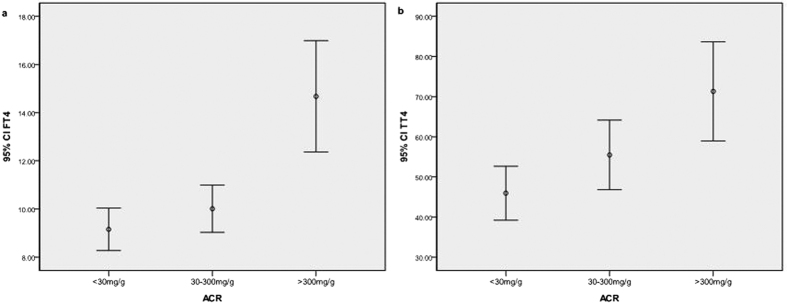
The mean and 95% CI of FT4 and TT4 in ACR group.ACR: urinary albumin to creatinine ratio; CI: confidence interval; FT4: free T4 (pmol/L); TT4: total T4 (mmol/L).